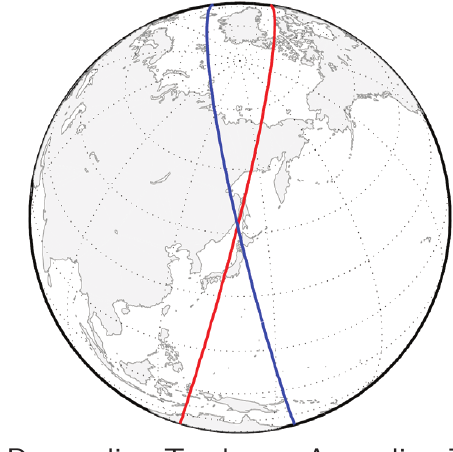
Fig. 1. OSIRIS often measures the same location twice over the